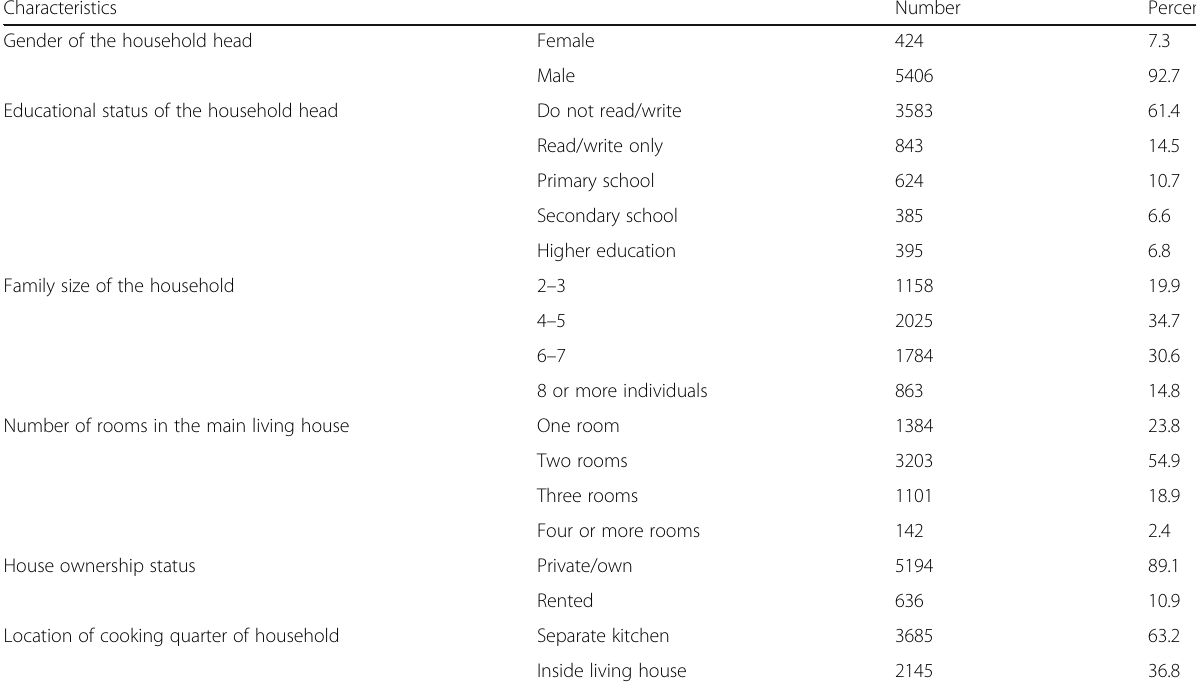
Table 1 Household and setting characteristics of study participants in Northwest Ethiopia, 2018 ( n = 5830) Characteristics